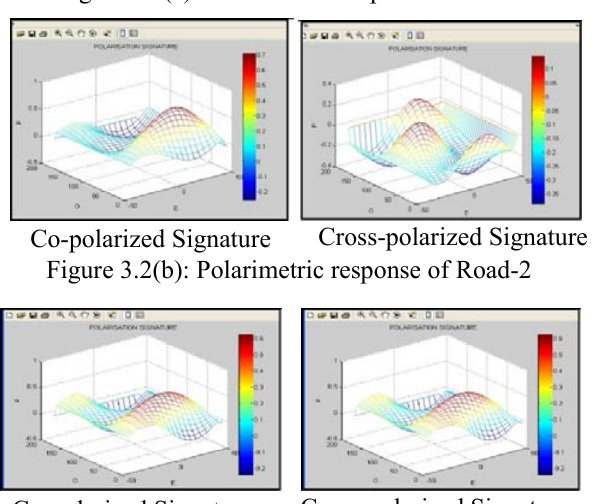
Co-polarized Signature Cross-polarized Signature Figure 3.2(c): Polarimetric response of Bridge